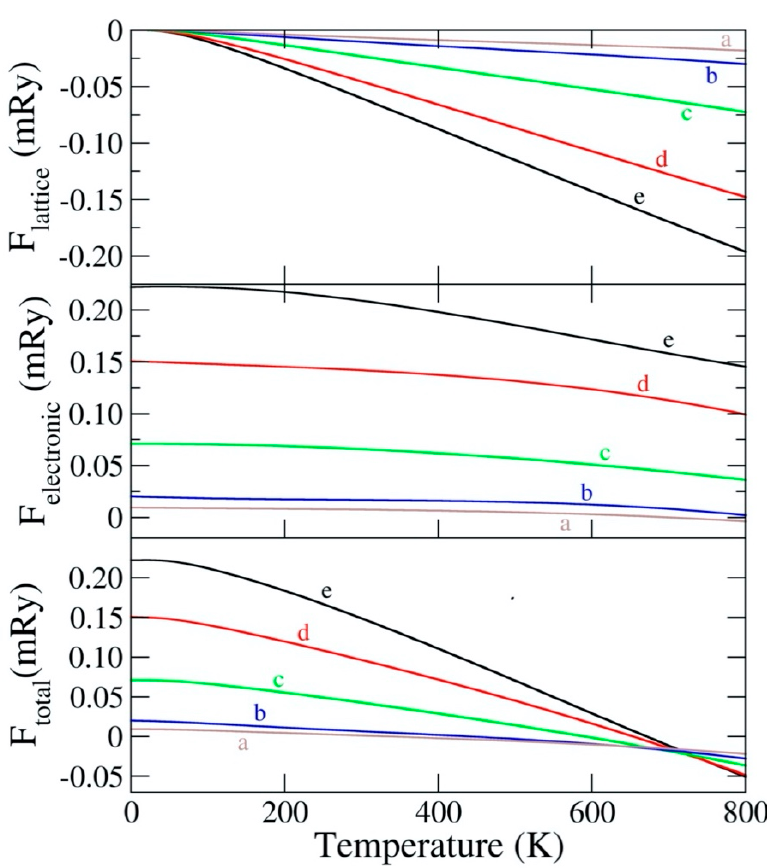
Figure 2. (Top) Free-energy contribution from lattice vibrations (F lattice ) within the QH-DG model. (Middle) Free-energy contribution (F electronic ) from DFT+OP electronic structure. (Bottom) Total free energy (F total = F lattice + F electronic ). The letters a, b, c, d, and e denote b/a axial ratios; 2.035, 2.025, 2.015, 2.005, and 1.995. All energies are relative to that of a calculation with b/a = 2.045 and where the c/a axial ratio and internal parameter y are kept fixed at 1.755 and 0.1009, respectively.